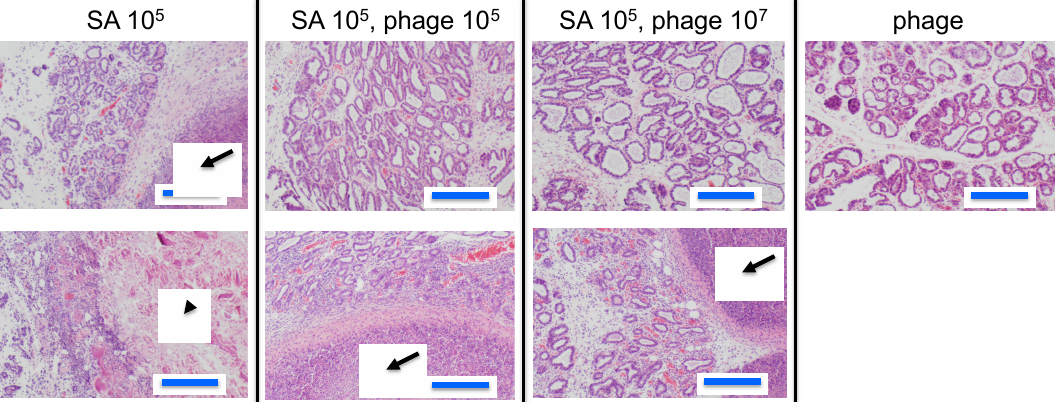
Figure 2. Pathological images of mammary glands in the mouse model of S. aureus mastitis. Arrows indicate abscesses and the arrowhead indicates an area of broken tissue. Blue bars indicate 200 µm long.